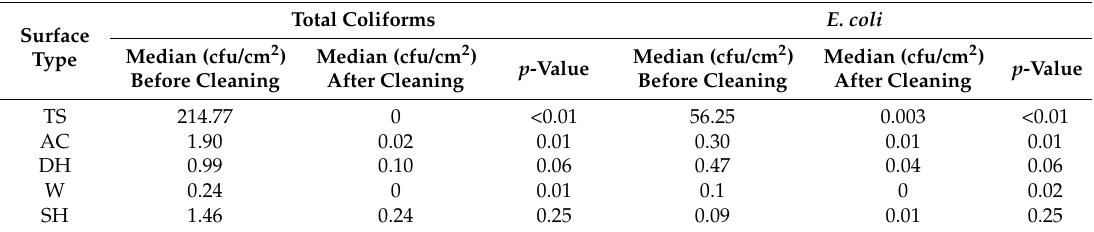
Table 3. Results of the Wilcoxon Signed Rank Test comparing the bacterial contamination of the community latrine surfaces, during the clean and dirty conditions (bolded if significant).